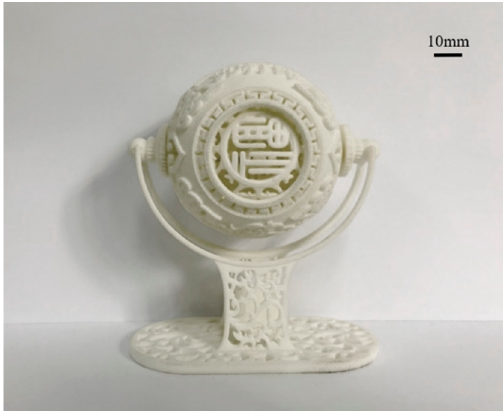
Figure 7. SLS printed artwork .